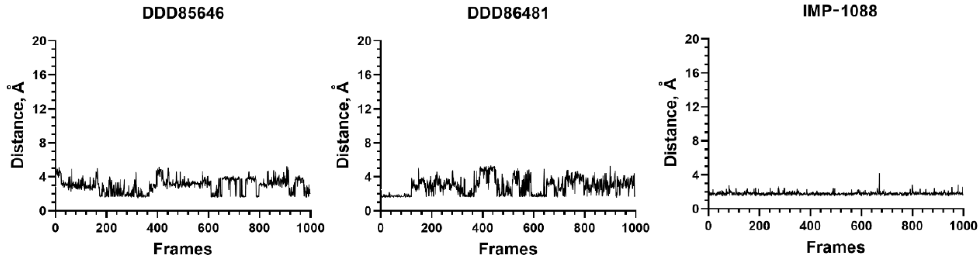
Figure 9. NMT inhibitors DDD85646, DDD86481, and IMP-1088 form stable complexes in MD simulations. Here the length of the salt bridge is plotted against the different frames of simulation. Note that the distances do not exceed 4 Å , indicating that the salt bridge is preserved and stable during the simulations.